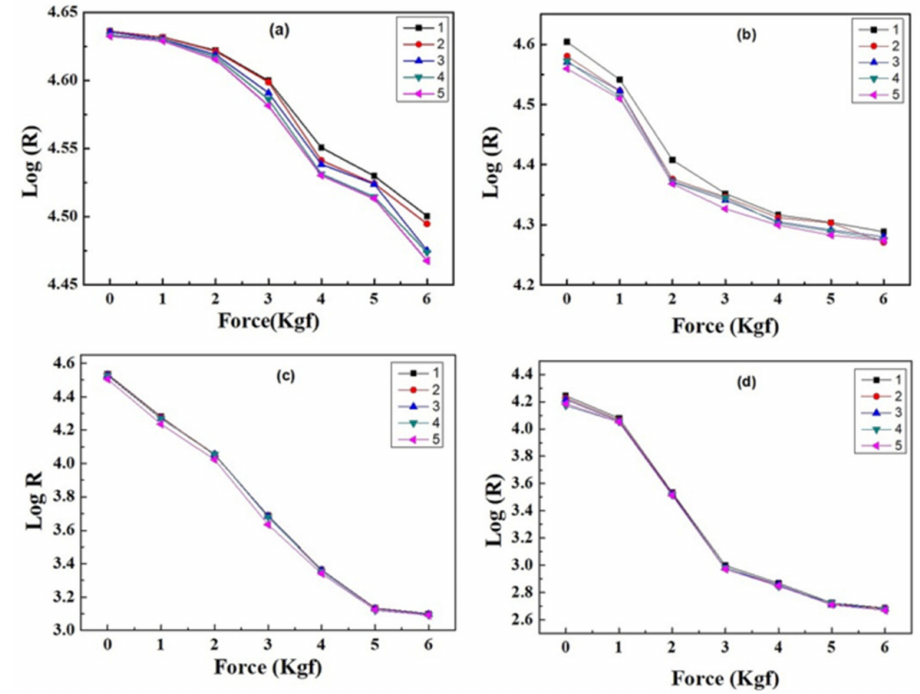
Figure 4A. Applied force versus Log resistivity. ( a ) TPU-MWCNT, ( b ) TPU-(MWCNT-PMMA) (5 µ m),